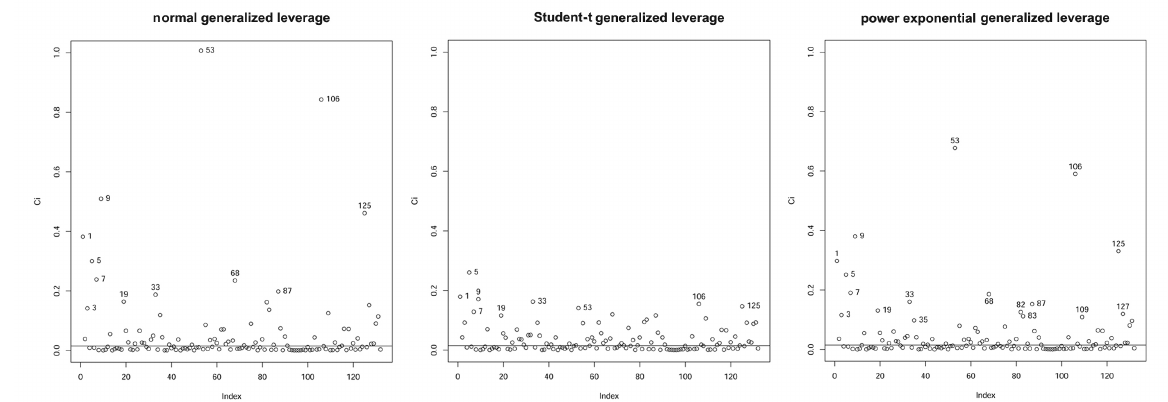
Figure 12. Plots of total local influence C h ( θ ) under the scale perturbations in the indicated model with data of monthly returns.